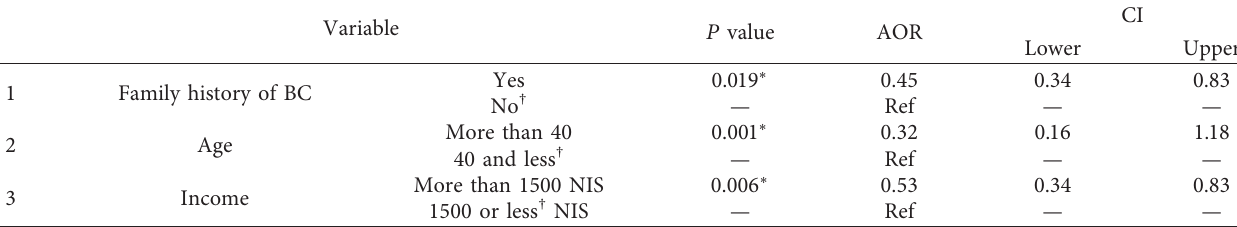
Table 6: Binary logistic regression of intimate partner violence with associated risk